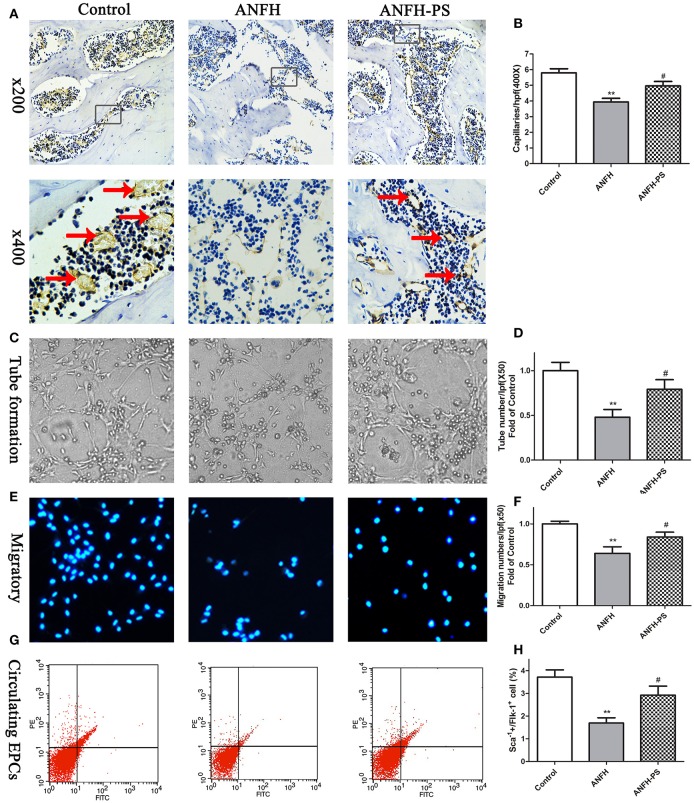
Pravastatin (PS) treatment enhanced femoral head angiogenesis and EPCs functions and numbers in Dex-induced ANFH rats. (A) Representative photomicrographs of CD31 staining on day 30; black arrows point to CD31-positive capillaries; boxed regions (×200) are shown at higher magnification (×400) below. (B) Quantitative analysis of capillaries per high-power field (hpf) showed that capillaries of femoral head in PS treatment were significantly increased on day 30 when compared with the untreated ANFH ones. (C,D) PS enhanced the tube formation capacity on Matrigel of BM-EPCs of ANFH-PS rats. (E,F) PS enhanced the migratory capacity of BM-EPCs of ANFH-PS rats. The cells that had migrated into the lower chamber were counted at each group. (G,H) PS increased the circulating EPCs number of ANFH-PS rats. Circulating EPCs phenotypes were characterized as these cells co-expressing Sca-1+ and Flk-1+ by fluorescence-activated cell sorting. Values are expressed as the mean ± SEM. n = 5 per group. **p < 0.01 vs. Control; #p < 0.05 vs. ANFH.